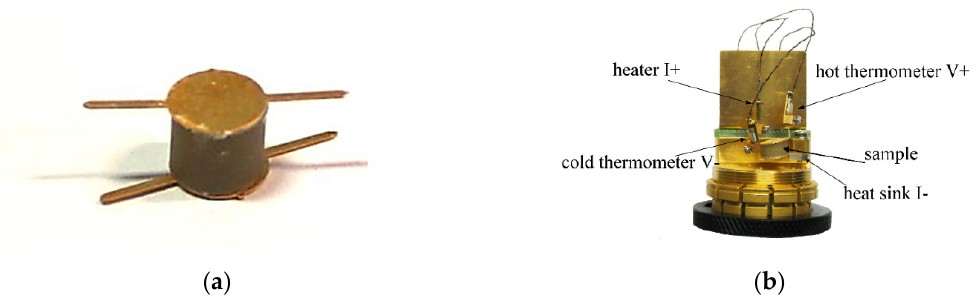
Figure 3. Macroscopic pictures of samples of obtained composites: ( a ) Sample of 6 mm diameter assembled with copper electrodes and ( b ) sample assembled in the PPMS (Physical Property Measurement System).